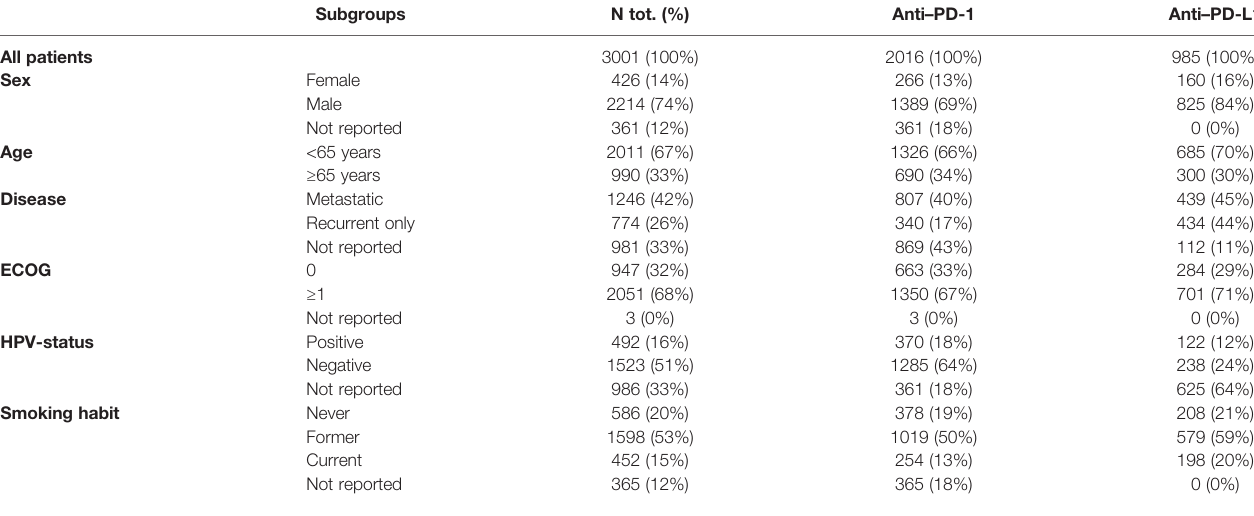
TABLE 1 | Patients ’ characteristics of the identi fi ed RCTs. Subgroups N tot.